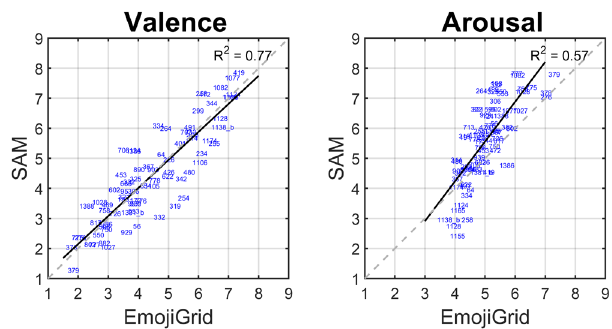
Figure 2. Relation between mean valence (left) and arousal (right) ratings obtained with the SAM and EmojiGrid for selected sounds from the IADS-E database. Labels correspond to the original identifiers of the stimuli (Yang et al. , 2018 ). The line segments represent linear fits to the data points.